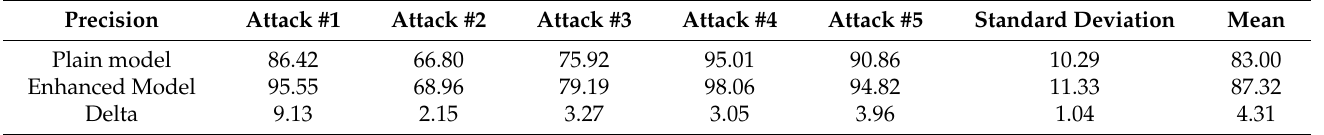
Table 2. Models’ predictions’ precision on live attacks.